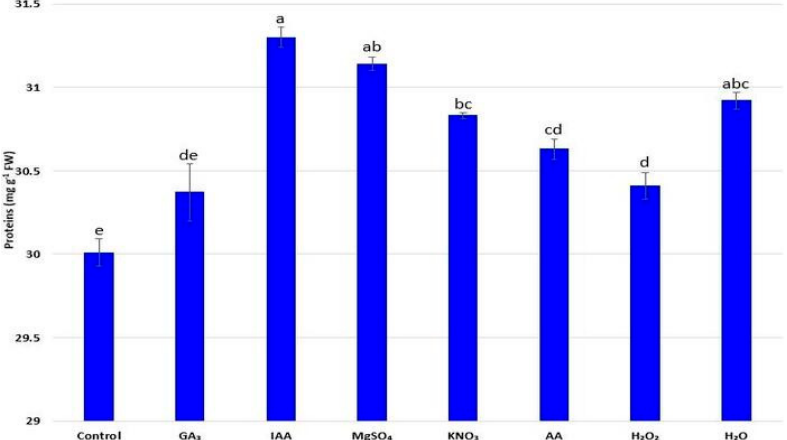
Figure 2. Influence of different priming treatments on the concentration of total soluble proteins in leaves of radish ( R. sativus ) seedlings; the values represent the means of six replicates ± standard error. Different letters indicate significant differences ( p ≤ 0.05) between treatments according to Tukey’s test.